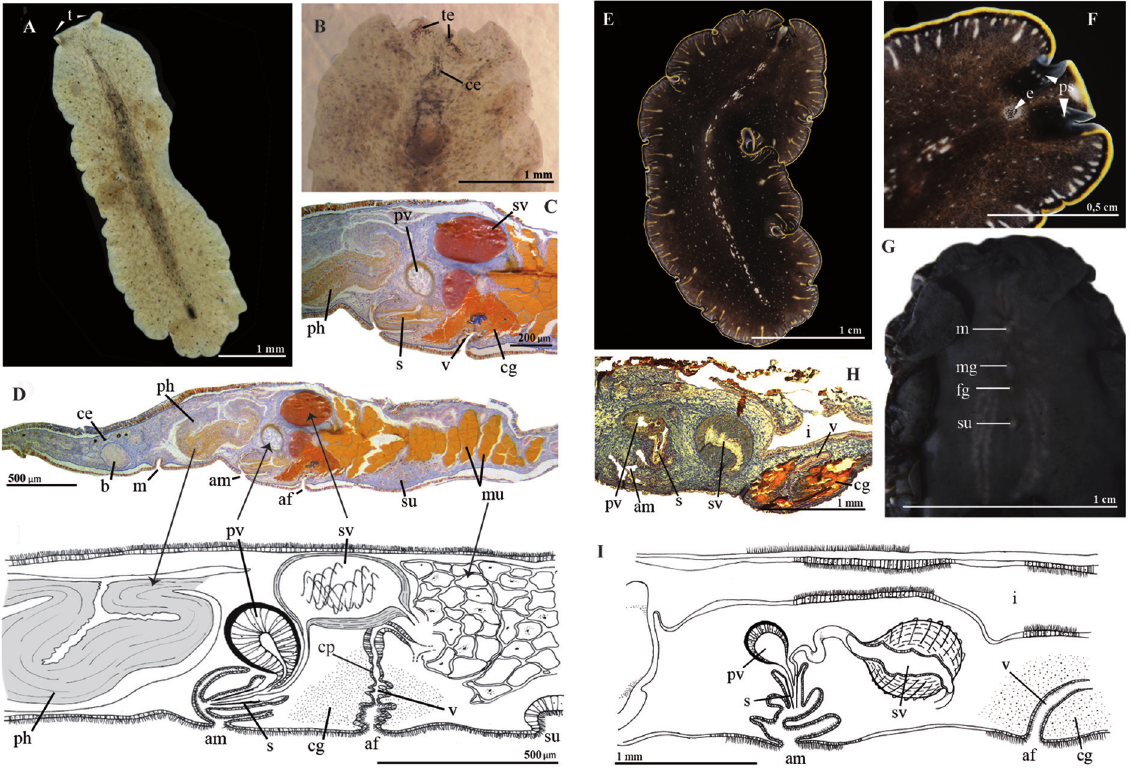
Fig. 3. A–D . Prostheceraeus crisostomum sp. nov. (MNCN 4.01/2684 to 2698). A . Whole live animal, dorsal view. B . Anterior region with cerebral eyes cluster and tentacles (black arrows). C . Histological section of the reproductive system stained with AZAN . D . Histological section of the whole animal stained with AZAN and sagittal reconstruction. – E–I . Pseudoceros rawlinsonae var. galaxy (MNCN 4.01/2729 to 2798). E . Whole live animal, dorsal view. F . Anterior region with eyes cluster and tentacles (white arrows). G . Whole live animal, ventral view. H . Histological sagittal section of male and female copulatory organ. I . Sagittal reconstruction of the reproductive system. Abbreviations: see Material and